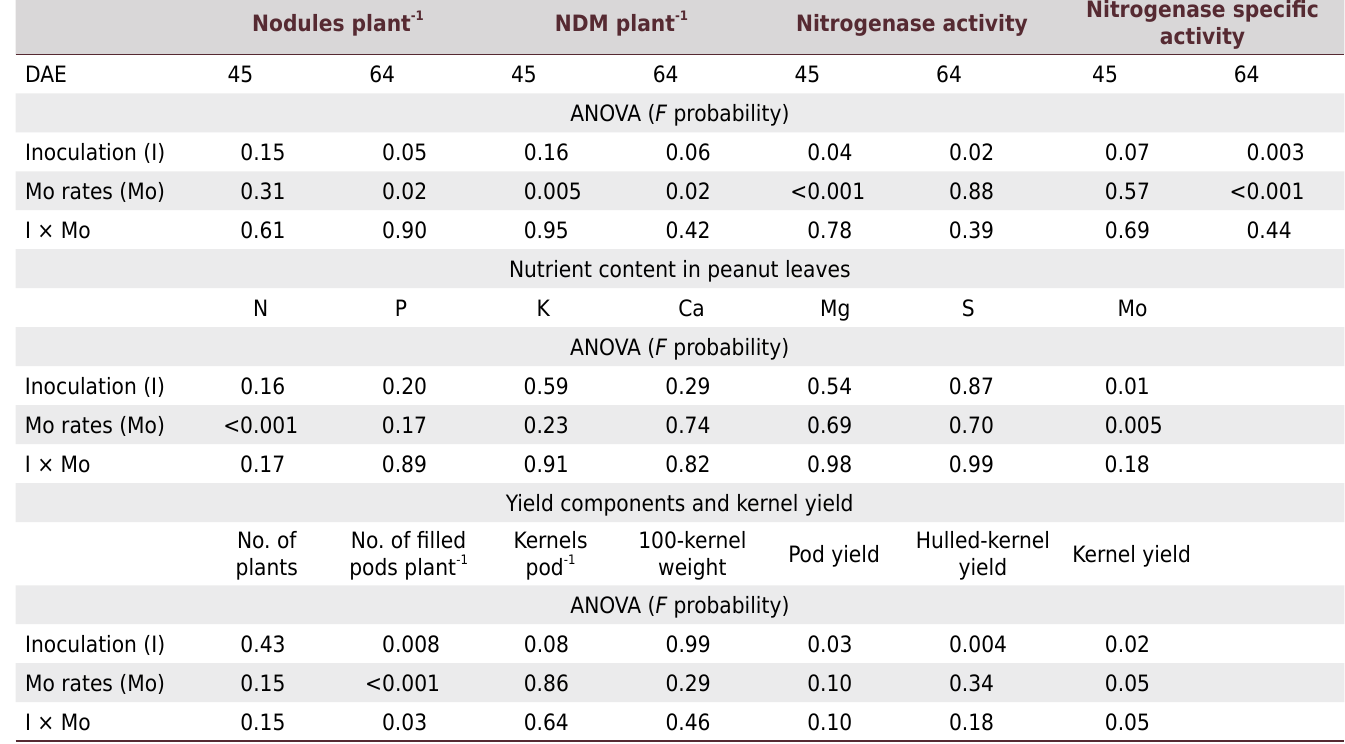
Table 2. Statistical significance (Pr > F) of inoculation, Mo rate, and their interaction on number of nodules plant -1 , nodule dry matter (NDM) plant -1 , nitrogenase activity, nutrient content in leaves, and yield components and kernel yield as a function of days after emergence (DAE) of